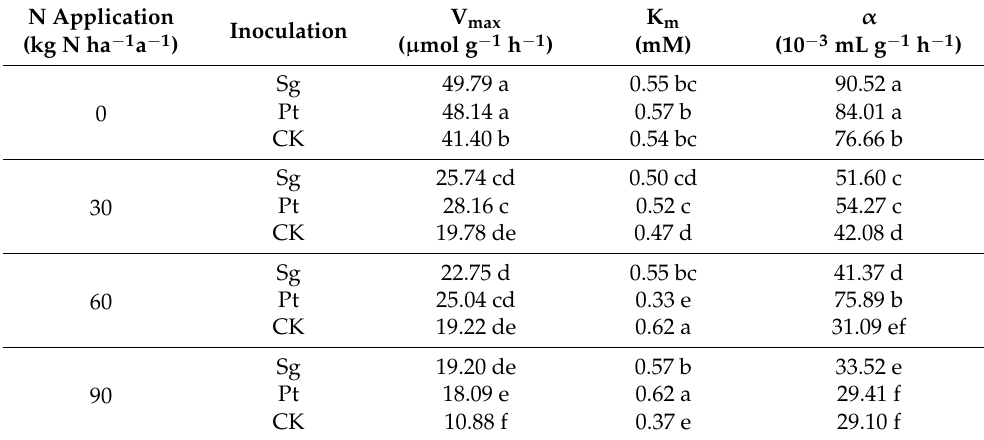
Table 4. The kinetic parameters of NH 4+ absorption in the roots of Pinus massoniana seedlings after nitrogen application and the inoculation of ectomycorrhizal fungi. N